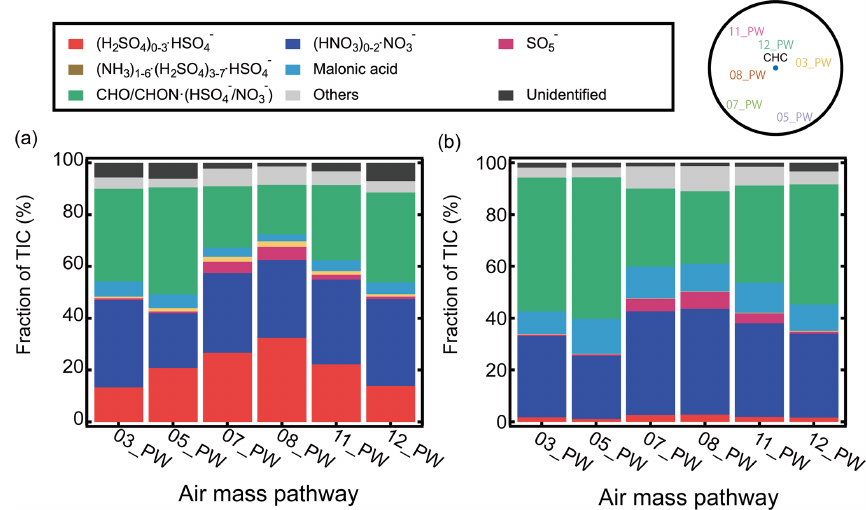
Figure 6. The fractions of the negative ion groups observed at CHC determined during the representative periods of each air mass pathway (described in Sect. 2.3.2) for (a) daytime (07:00–19:00) and (b) nighttime (19:00–07:00). A sketch of the horizontal profile of the air mass pathways (Fig. 2a) is shown in the upper-right corner for